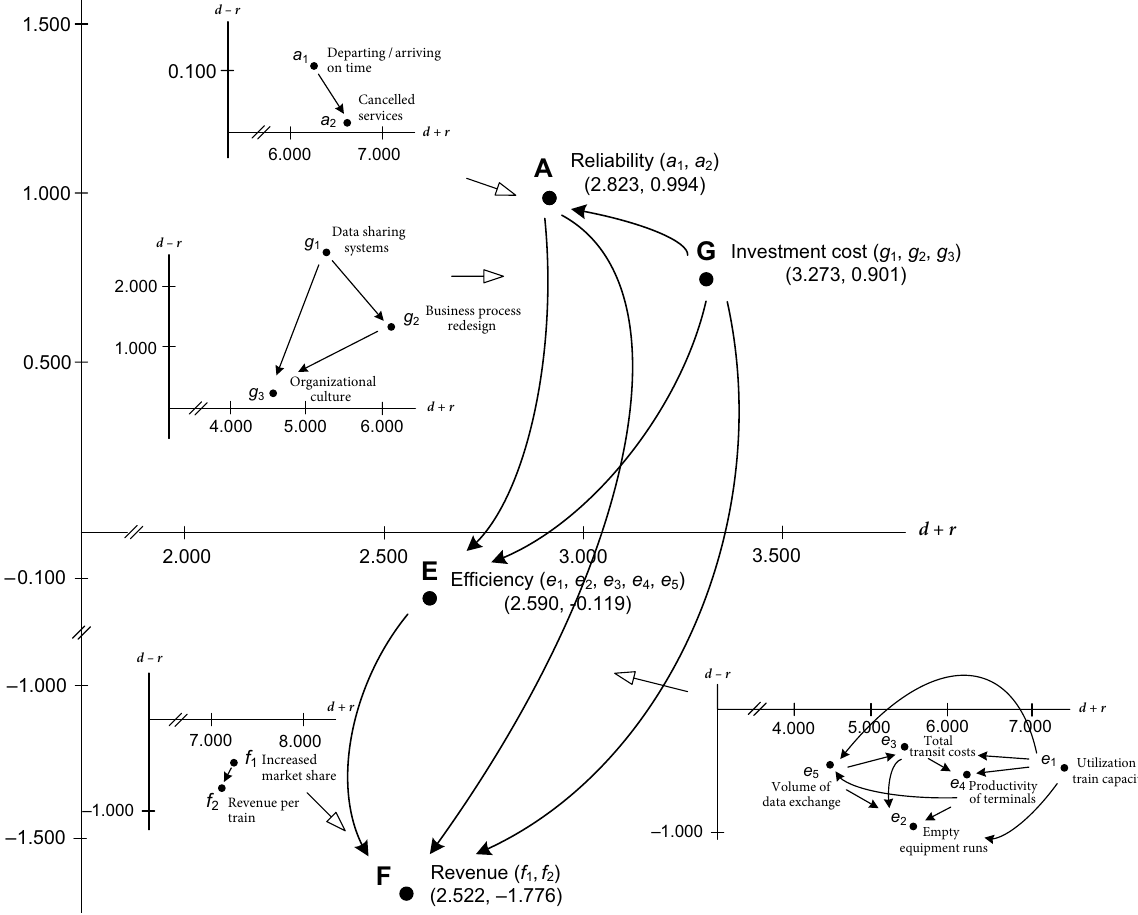
Figure 12. Causal diagram of total relationships: railway operators’ Table 8. Influential weights of DEMATEL–ANP for each criterion obtained by